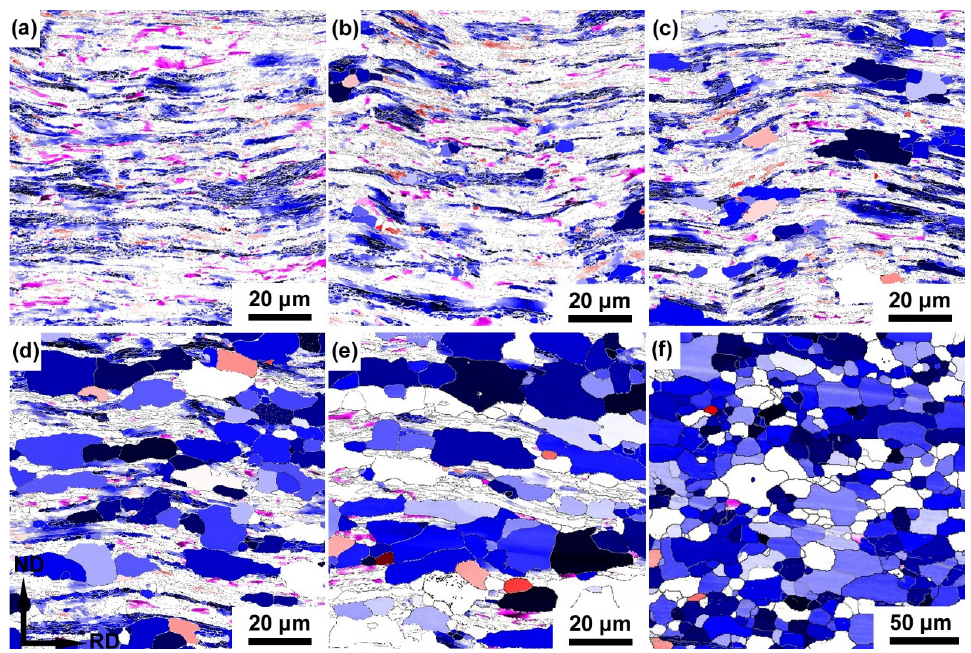
Figure A1. Texture components and their corresponding Euler angles of the cold rolled IF steel annealed at 600 ◦ C for ( a ) 2h, ( b ) 4h, ( c ) 8h, ( d ) 16h, ( e ) 32h and ( f ) 64h. The texture component of (cid:104) 111 (cid:105) //ND is presented by gradient